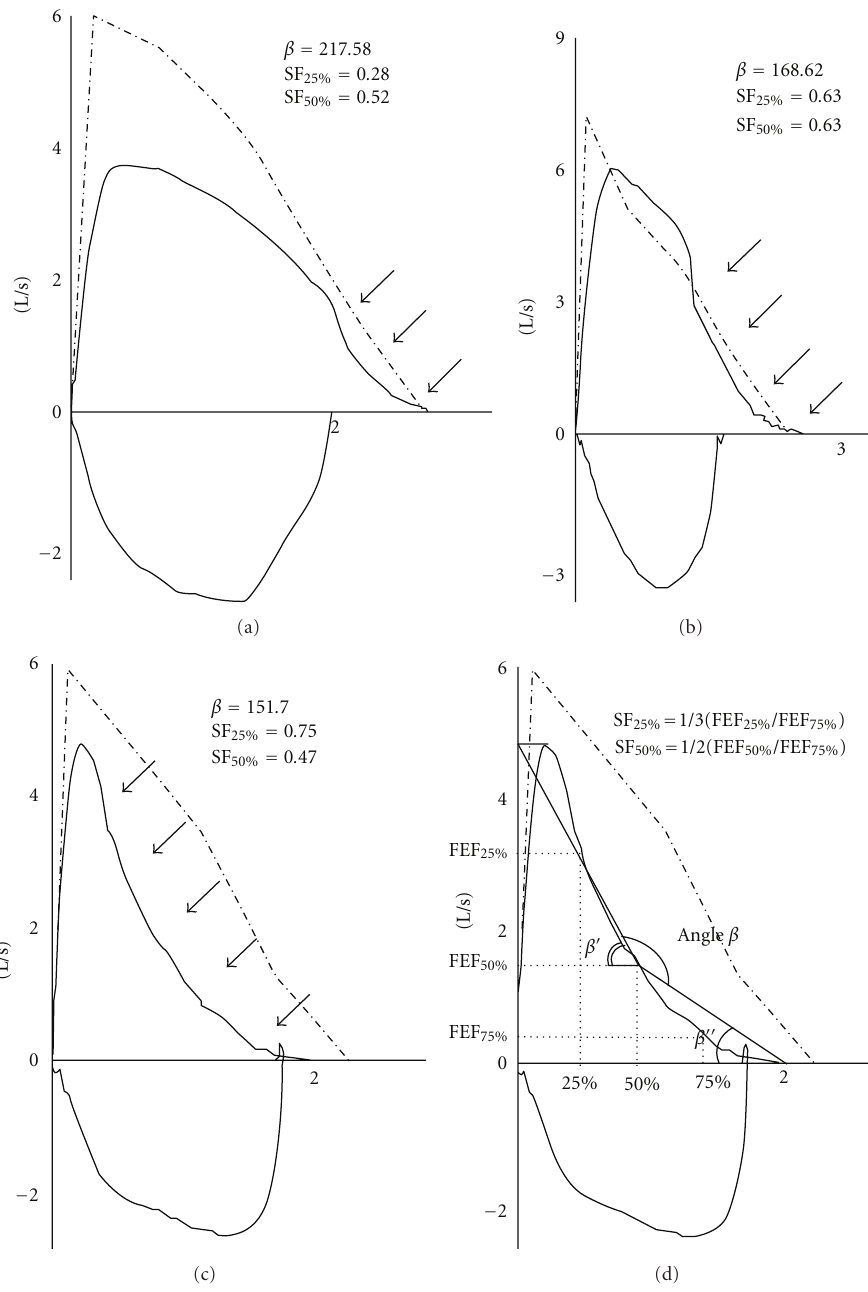
Figure 1: (a–c) Representative cases of various patterns of concave maximal expiratory flow-volume curves in the subjects analyzed in this study. Arrows indicate the concave region of the curve. (d) Calculation of angle β and shape factors (SF 25% and SF 50% ) from standard spirometric